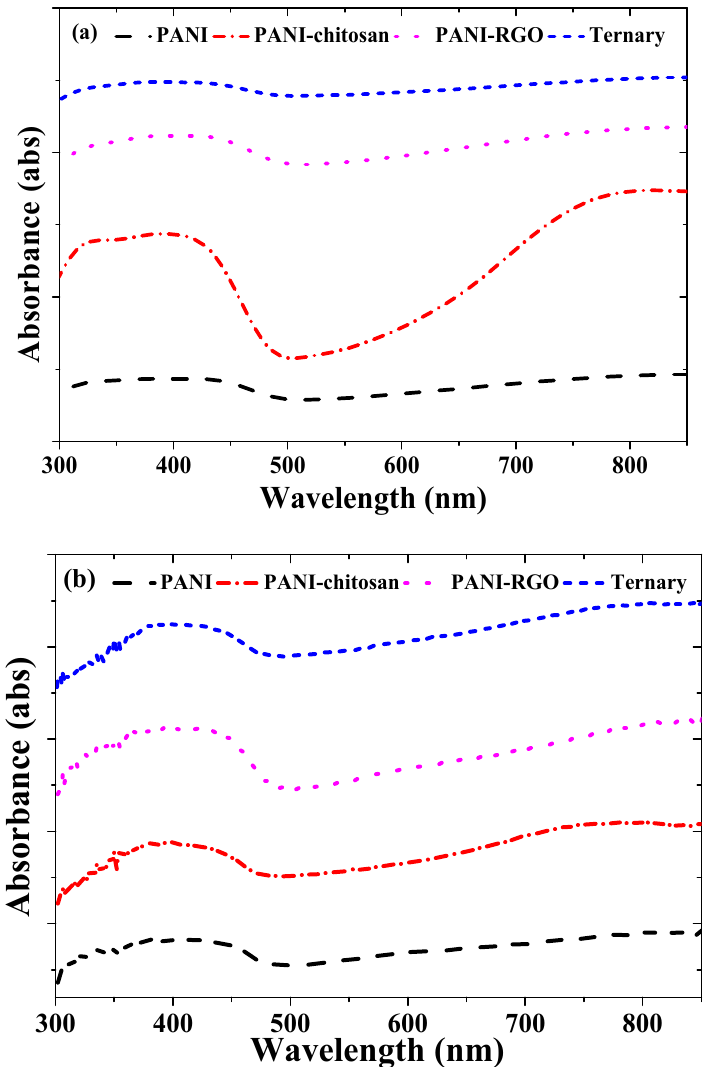
Figure 1. UV-VIS spectra of ( a ) PANI, PANI-chitosan, PANI-RGO and Ternary composites dispersed in PTSA ( b ) PANI, PANI-chitosan, PANI-RGO and Ternary composites dispersed in NMP.